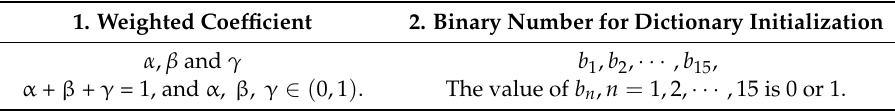
Table 4. Details of the parameters needing optimization.